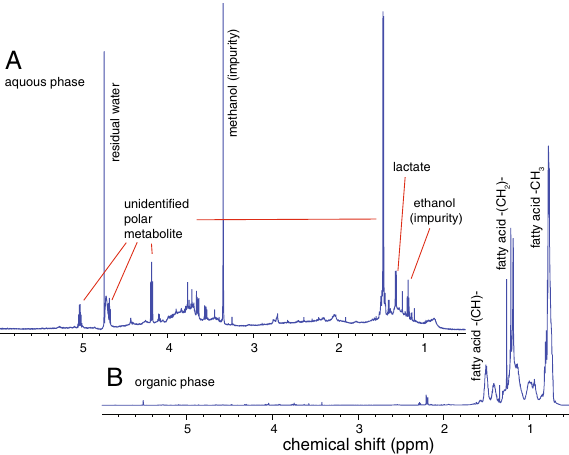
Figure 1. 1D 1 H NMR spectra of the aqueous ( A ) and organic ( B ) fractions after chloroform–methanol-water extraction of the eco-corona solution. ( A ) The aqueous fraction is dominated by lactate and an unknown metabolite. The unknown metabolite consists of a methyl (CH 3 ) group connected to a methine (CH) with a hydroxyl (OH) or nitrogen and followed by a methylene (CH 2 ) group with an unknown substituent. ( B ) The organic phase is dominated by fatty